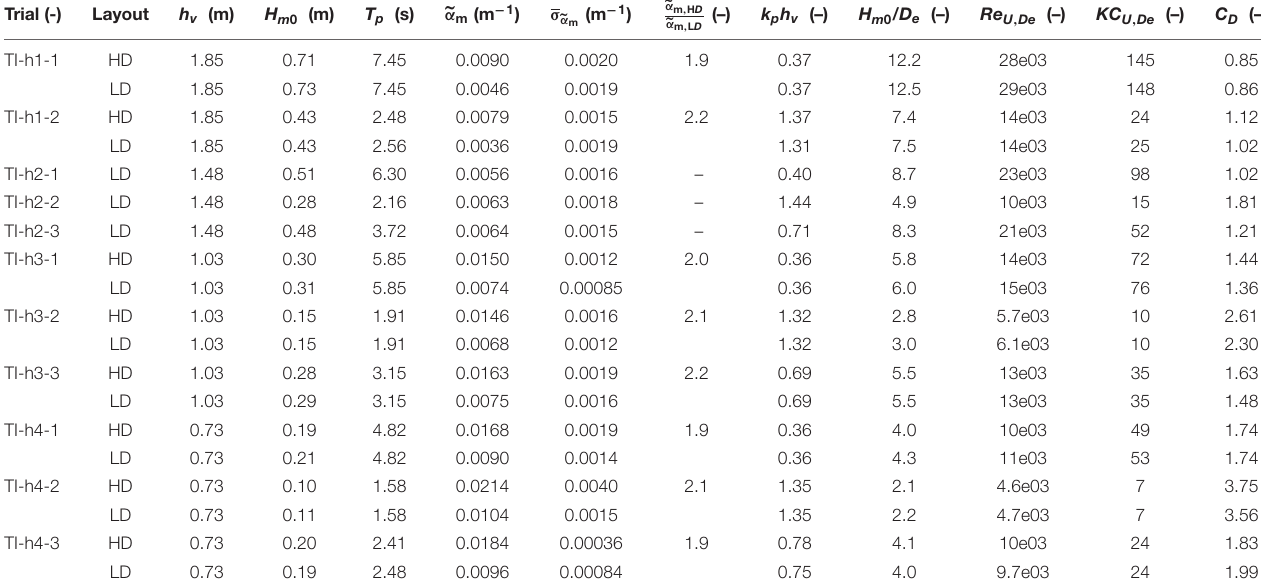
TABLE 3 | Measured H m 0 and T p values at PD18-1, e α m , HD/LD ratio of the e α m coefficient, k p h v , H m 0 /D e , Re U , De , KC U , De , and C D values for random wave cases. Trial (-)